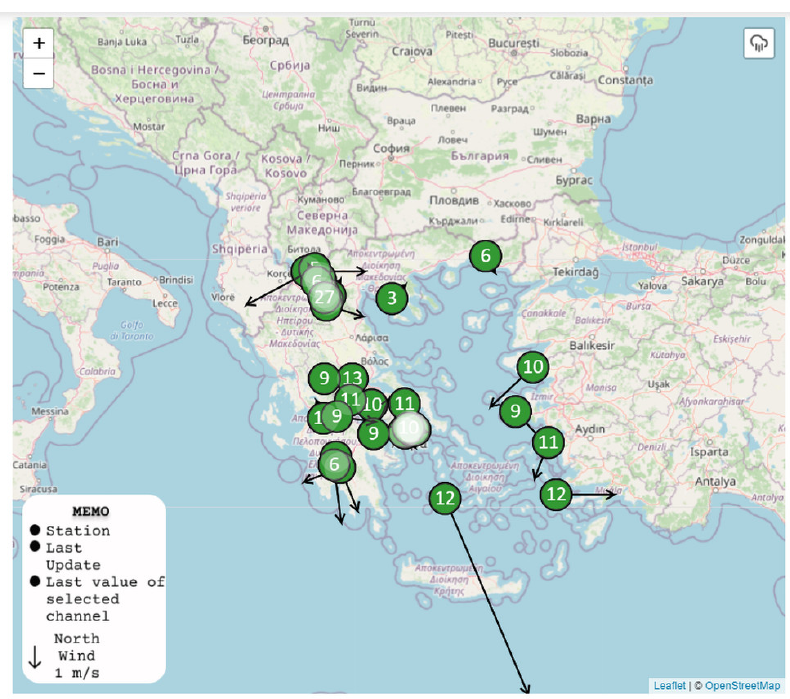
Figure 2. Map with metrological parameters for every network station (value inside the circle corresponds to ambient temperature).